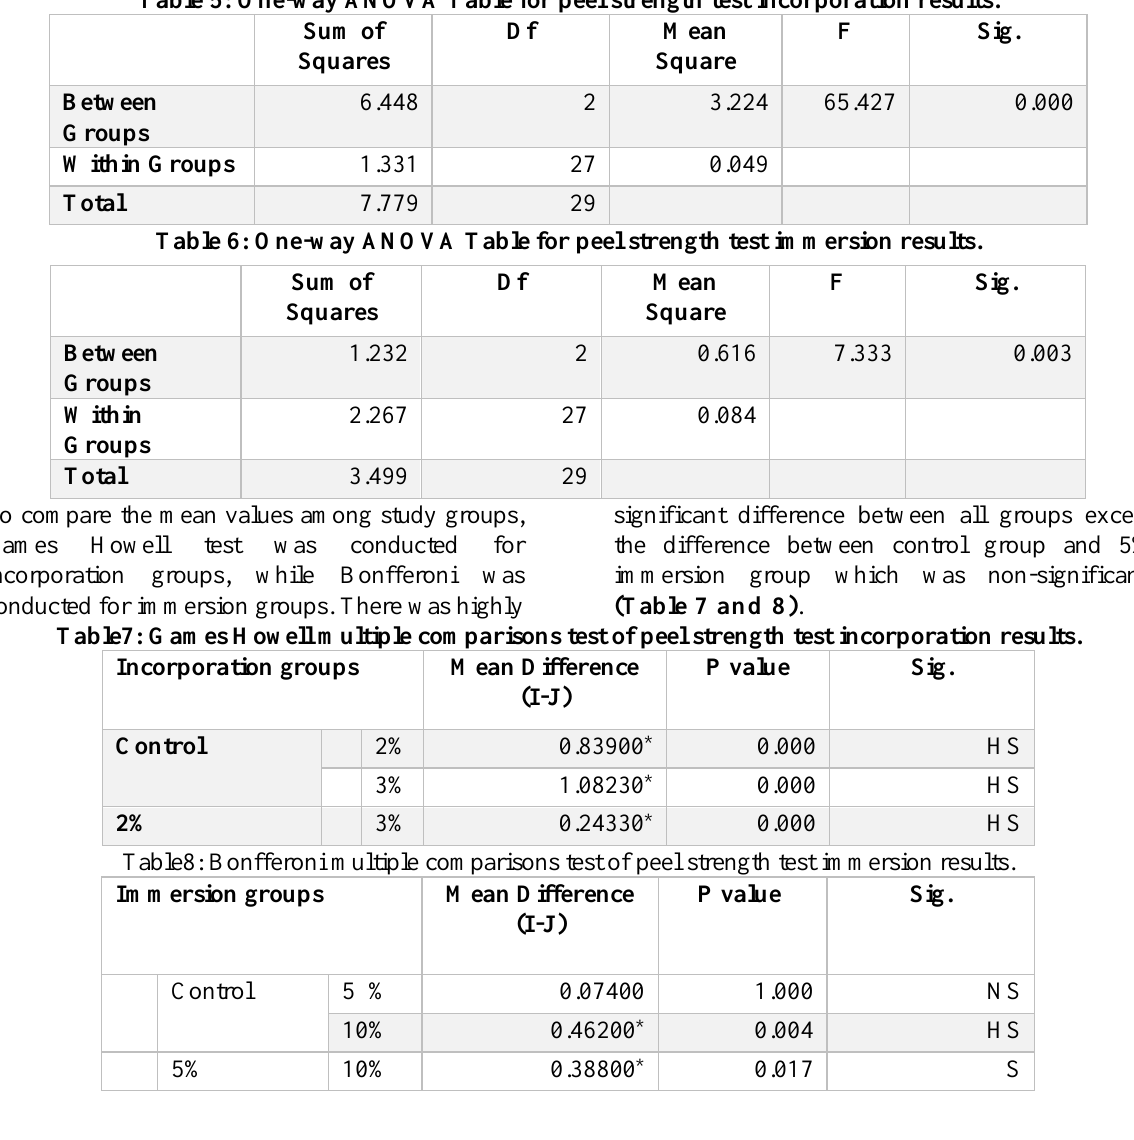
Table 5: One-way ANOVA Table for peel strength test incorporation results.